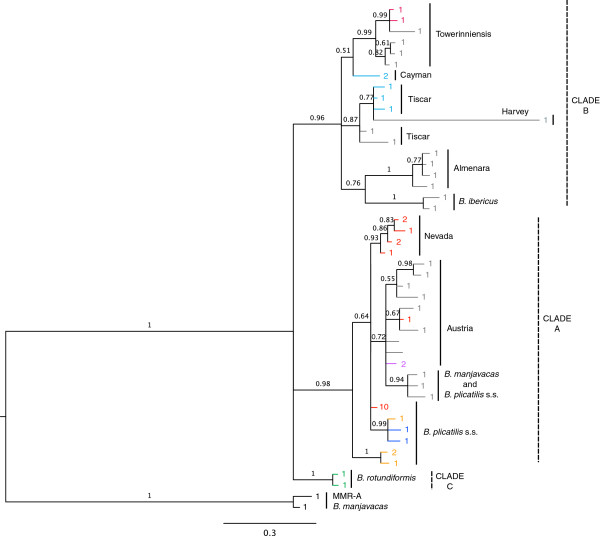
Bayesian trees of mmr-b terminal repeat coding sequences. Posterior probabilities are shown along the branches. Numbers at the tip of each branch indicate the number of identical repeats represented by that branch; colors are the same as in Figure 
2. Phylotype and major clade designations are shown to the right.